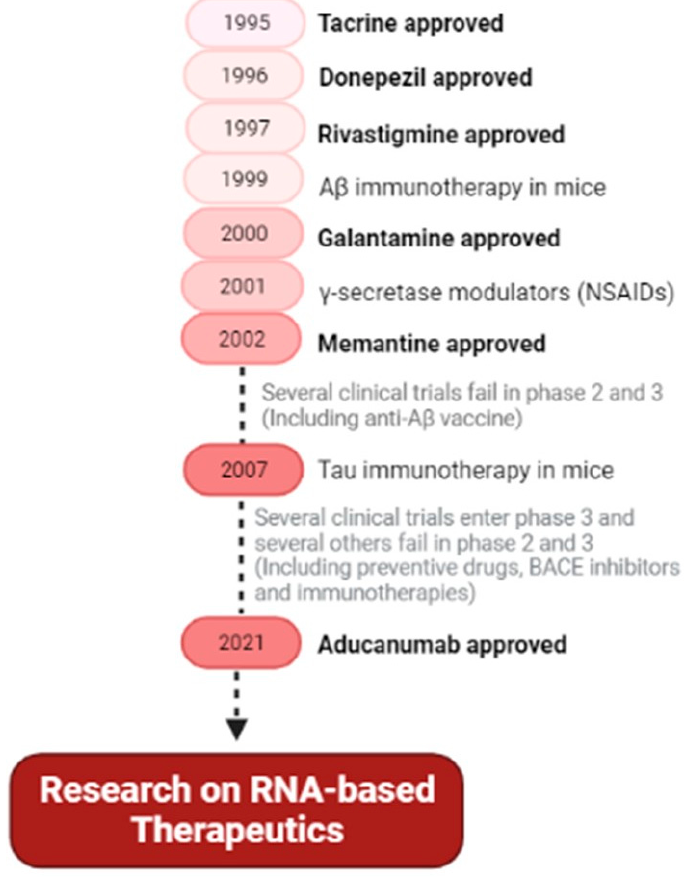
Figure 7. Main hallmarks and future perspective of therapeutic drugs for Alzheimer’s disease. Summary of the FDA-approved drugs for AD and the main types of drug research (secretase modulators, anti-A β vaccines, preventive drugs, and immunotherapies), and future therapeutic trends based on RNA. (NSAIDs—nonsteroidal anti-inflammatory drugs).